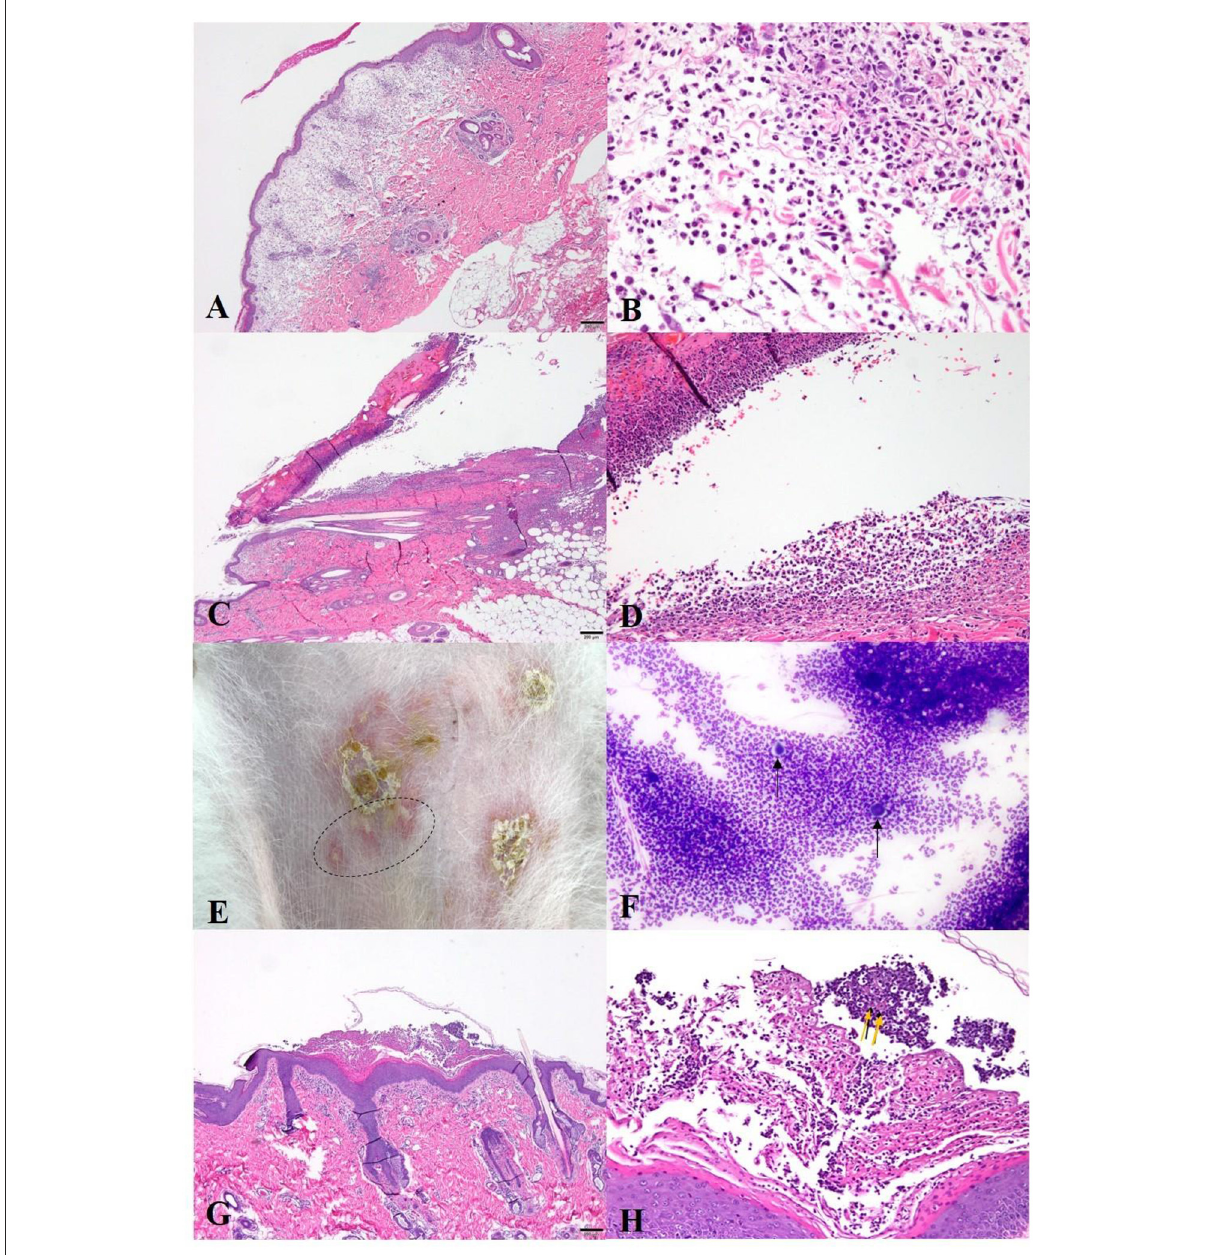
FIGURE4 Histopathology (H&E staining) and cytology (Diff quick staining) of the [ (A,B ): Case 1]. (A) Marked edema with diffuse inflammation in the dermis(40x); (B) High magnitude of (A) . Inflammatory cells (neutrophils, mast cells, and macrophages) are infiltrated in the edematous dermis (400x); [ (C,D) : Case 2] (A) Epidermal necrosis and separation of the epidermis and dermis (40x); (D) Infiltration of the inflammatory cells (neutrophils, macrophages) in separated interface sites (200x); [ (E–H) : Case 3] (E) Crusts and intact pustules (dot circle) on the abdomen; (F) Acantholytic cells (black arrows) and numerous neutrophils on the cytology of the pustules (400x); (G) Pustules in the hyperplastic stratum corneum in histopathology (40x); (H) Acantholytic cells (yellow arrows) that are surrounded by inflammatory cells (neutrophils, macrophages) in pustule